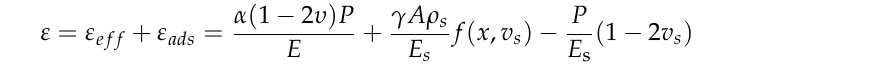
Figure 12. Variation of the volumetric strain versus the mean pore pressure (the mean of upstream and downstream pressures) of super critical CO 2 at 18 and 20 MPa confining pressures.